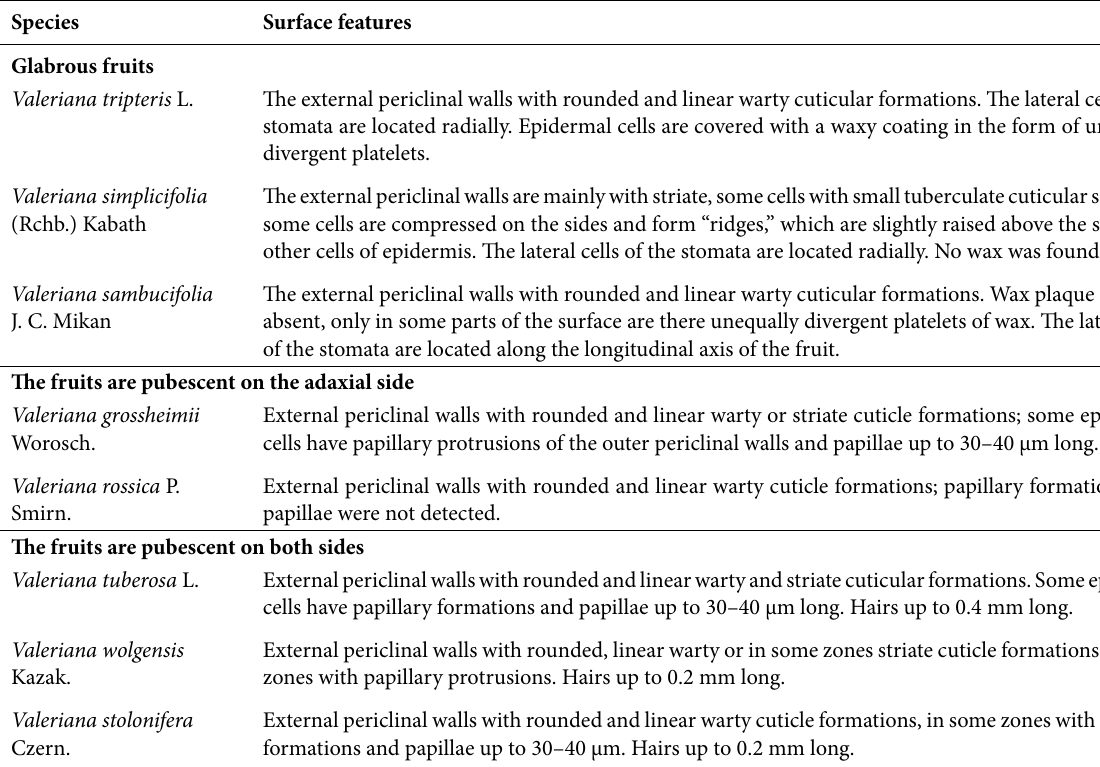
Table 1 Main differences in microstructure of fruit surfaces of studied Valeriana spp.